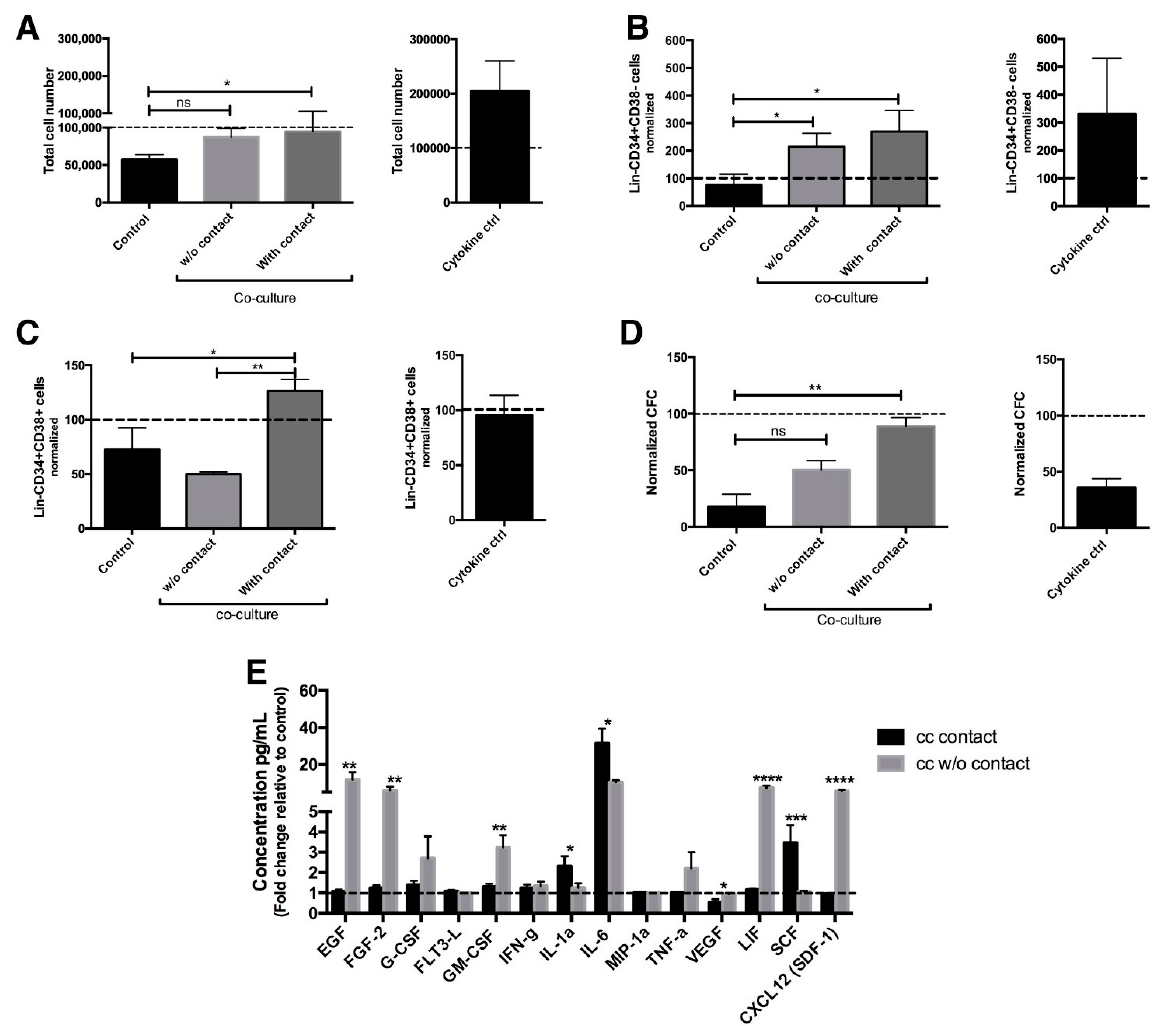
Figure 1. Co-culture with endothelial cells allows the CML primitive cells’ maintenance. A hundred thousand Lin-CD34+ cells from CML patients were co-cultured with or without contact with EC for 3 days in absence of any cytokine supplement. Basal culture medium (control) or StemSpan medium supplemented with cytokines (cytokine ctrl) were used as negative and positive controls, respectively. ( A ) Total CML cell number was evaluated after three days in EC co-cultures. The cells were counted with Trypan blue staining and non-viable cells were excluded. ( B )Stem (Lin-CD34+CD38-) or ( C ) progenitor (Lin-CD34+CD38+) cell number was evaluated after 3 days of co-culture. All data were normalized to the initial cell numbers in individual cell subsets obtained (post-enrichment and